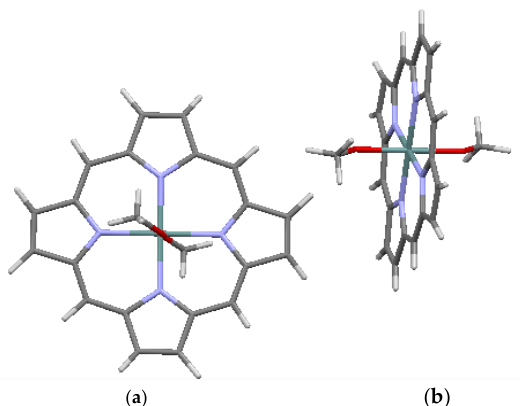
Figure 8. Ge-porphine, after data of [7,18]: ( a ) top view; and ( b ) side view. Dark green = Ge, red =